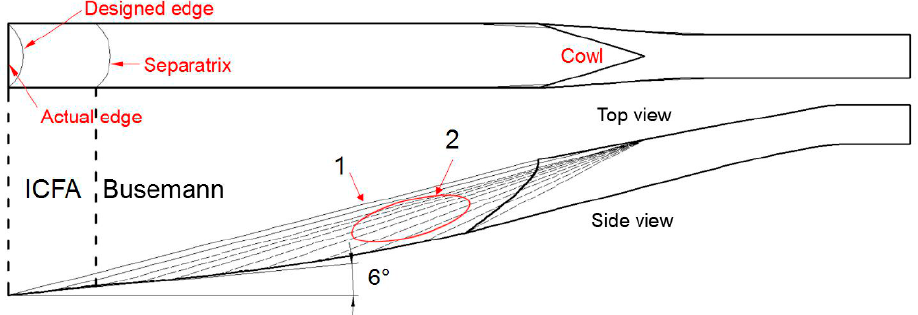
Figure 3. Hypersonic inlet design.